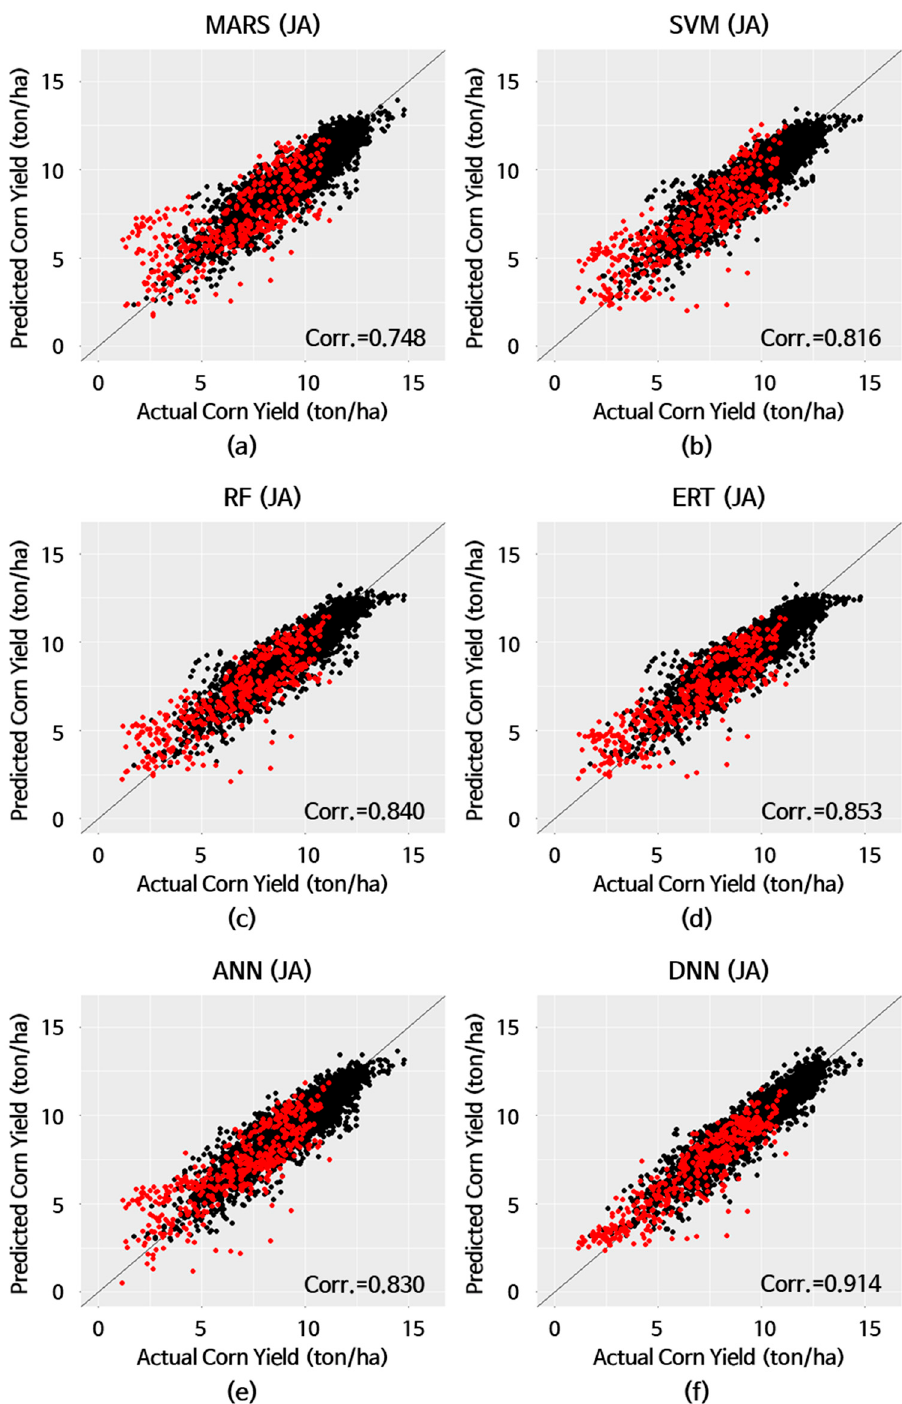
Figure 8. Actual and predicted corn yields from the leave-one-year-out blind tests for 2006–2015: Red dots, heatwave exceeding five days; black dots, all other cases. ( a ) Multivariate adaptive regression spline (MARS); ( b ) Support vector machine (SVM); ( c ) Random forest (RF); ( d ) Extremely randomized tree (ERT); ( e ) Artificial neural network (ANN); ( f ) Deep neural network (DNN).